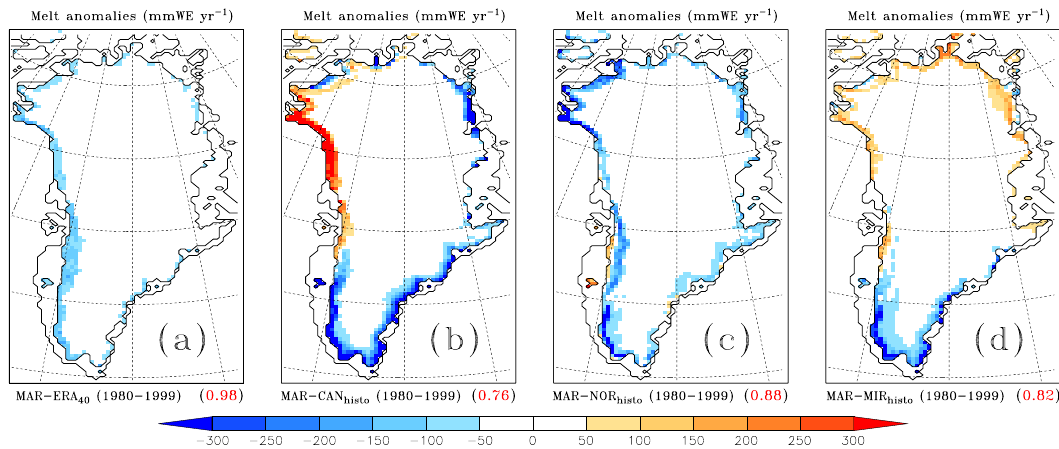
Fig. 3. (a) Annual melt anomalies (mmWEyr − 1 ) of MAR-ERA 40 run compared to the MAR-ERA Int simulation (see Fig. 2) over the 1980– 1999 period. In the bottom right side of the view, in red, is the melt skill score of MAR-ERA 40 compared to MAR-ERA Int . (b–d) The same as (a) , but for the MAR-CAN histo , MAR-NOR histo and MAR-MIR histo